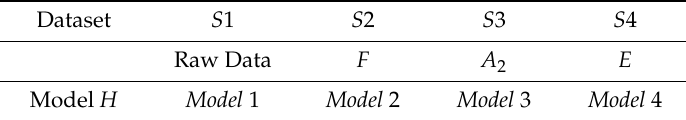
Table 1. Data and model description.